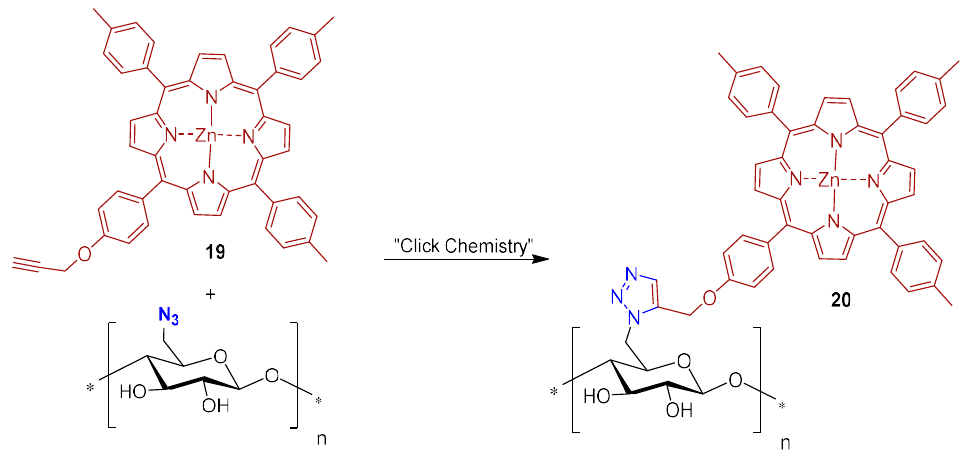
Figure 15. Synthetic methodology used to covalently graft complex 19 with a propynyloxy substituent in azido cellulose fabric. (adapted from reference [157]).